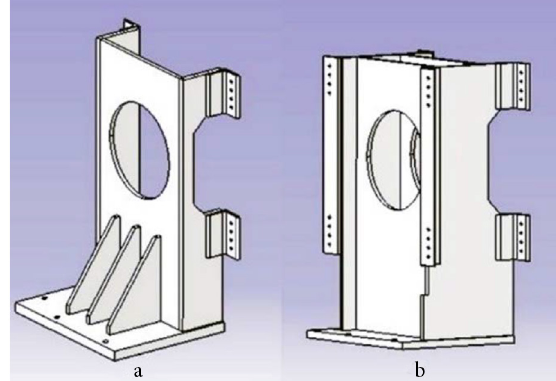
Fig. 2. Gearbox assembly